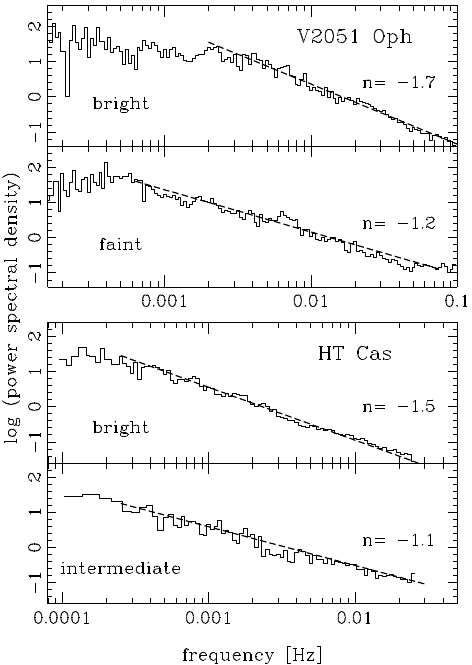
Figure 1: Optical (B-band) power density spectra for V2051 Oph (top) and HT Cas (bottom) at two different brightness levels in their quiescent states (differences between bright, intermediate , and faint are 1-2 orders of magnitude lower than differences between outburst and quiescence). Dashed lines show the best-fit power- law in each case; the corresponding power-law index n is depicted in each